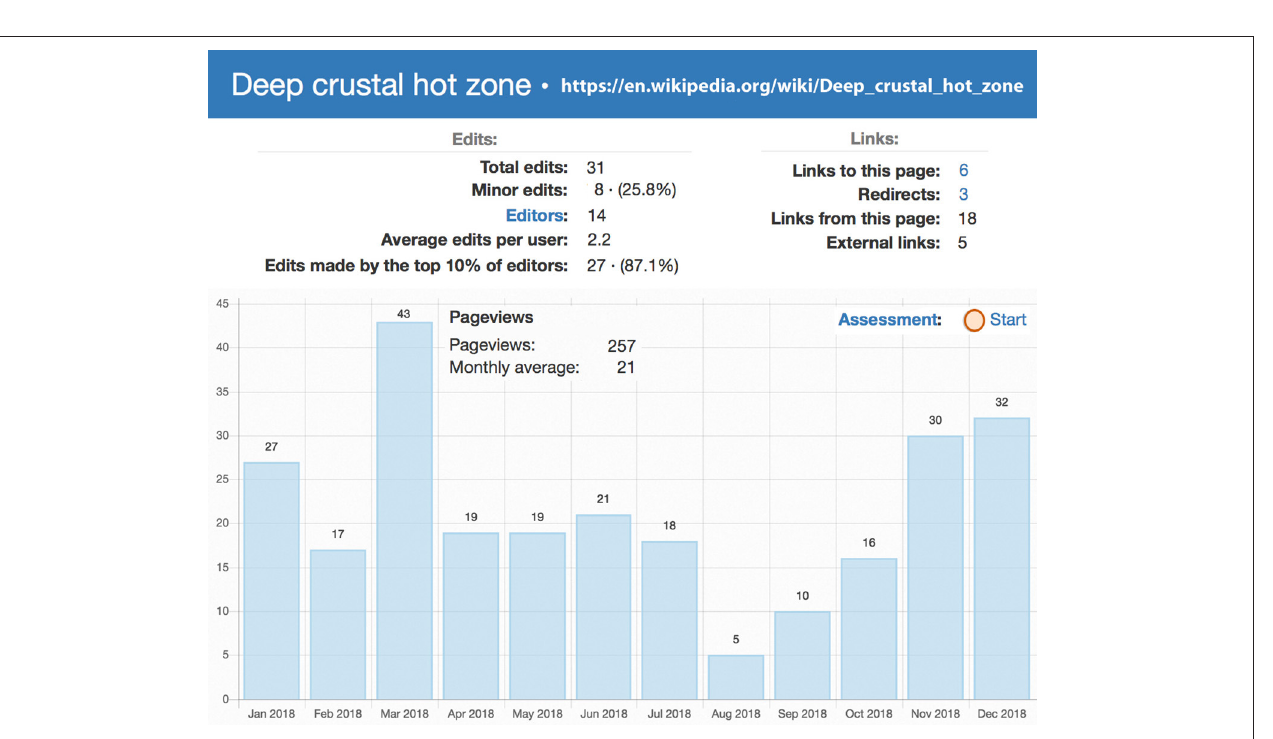
Frontiers in Education |